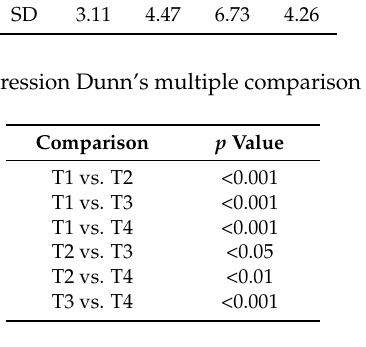
Table 3. Mean and SD of T Lymphocytes (CD3).